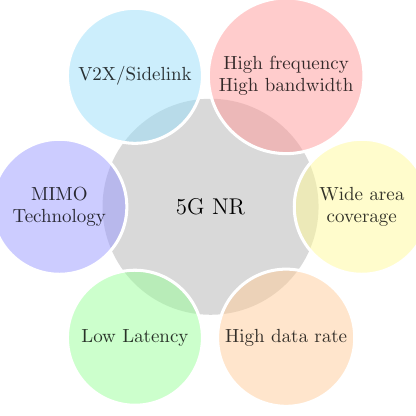
Figure 7. 5G NR enabler for improved robot